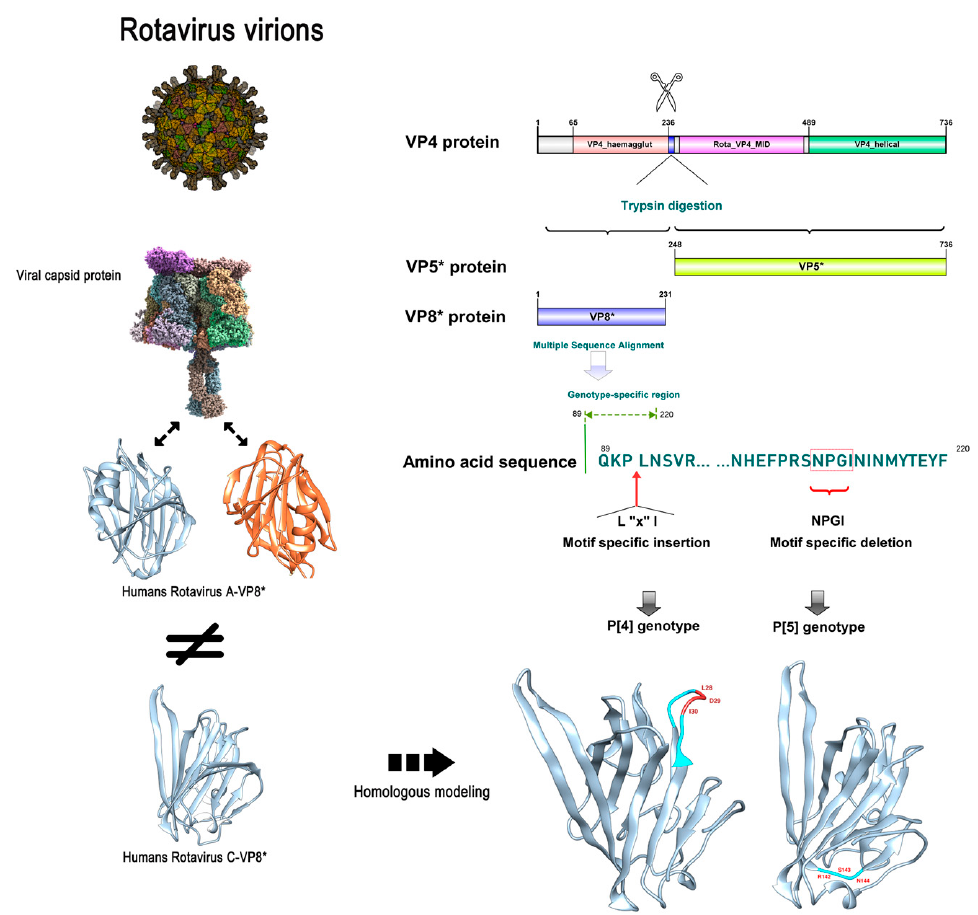
Figure 4. Schematic diagram of the specificity differences of the inserted and deleted motifs for RVC genotype P [2]/P [4]/P [5]. The structure of rotavirus virions and the VP8* structure of RVA were obtained from the Protein Data Bank online website (PDB: 4V7Q). RVC VP8* 3D structure (PDB: 5ZHG). The VP8* 3D structure of the P [4]/P [5] genotype was obtained by SWISS-MODEL homology modeling. In addition, the specific differences are as follows: for human P [2], swine P [4] has the insertion of the ‘L-X-I’ (where X is an unknown amino acid) motif, while swine P [5] has the deletion of the ‘N-P-G-I’ motif.